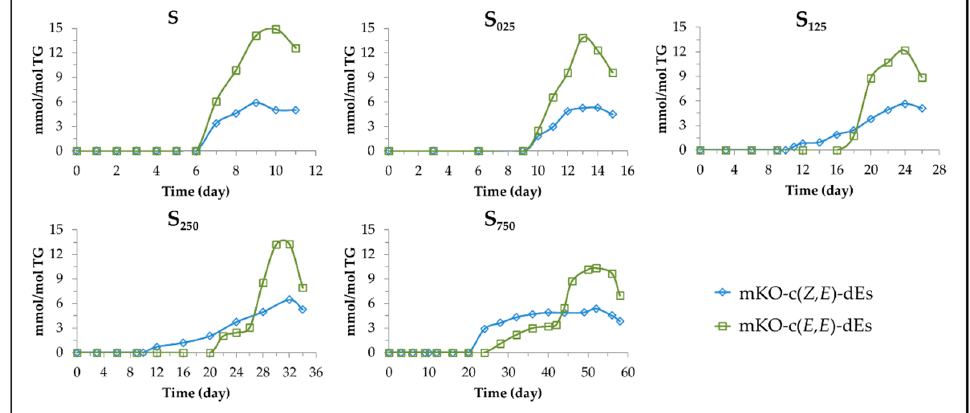
Figure 9. Evolution of the concentration of mKO-c( Z,E )-dEs and mKO-( E,E )-dEs throughout the